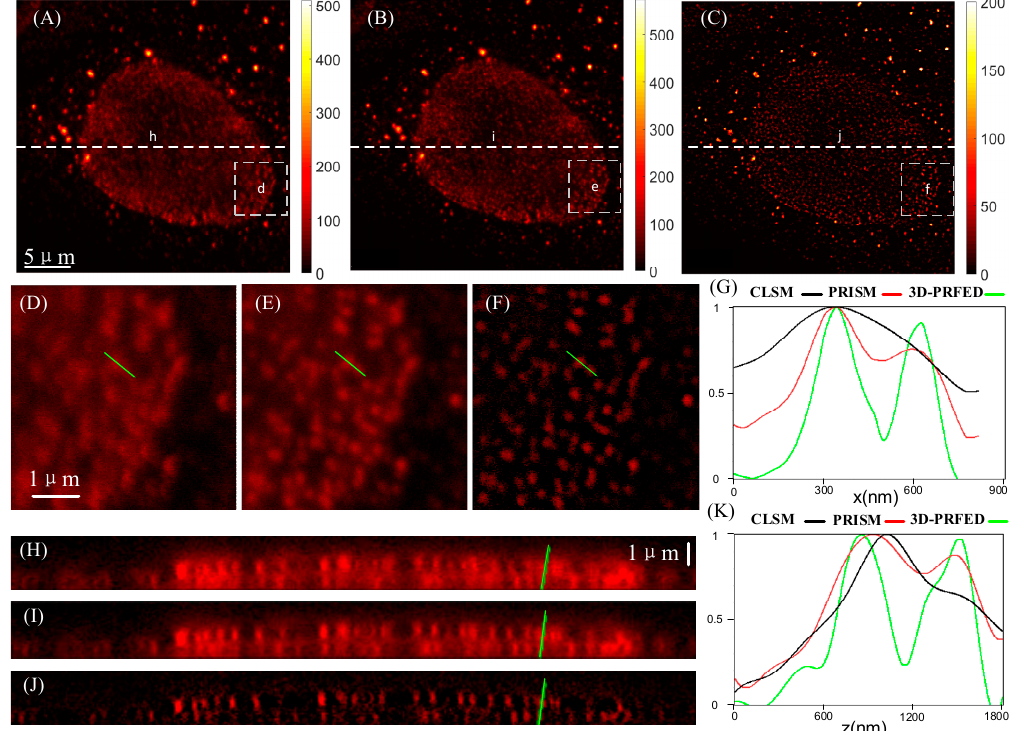
Figure 7. Nuclear pore complex results in CLSM, PRISM, and 3D-PRFED ( γ = 0.7). ( A ) The CLSM image of this NPC sample at 350 nm plane. ( B ) The PRISM image of this NPC sample at 350 nm plane. ( C ) The 3D-PRFED image of this NPC sample at 350 nm plane. ( D – F ) are the local enlarged images in the dashed boxes of ( A – C ) respectively. ( G ) The normalized line profile along the green line in ( D – F ). ( H – J ) are the cross-section views along the dashed line in ( A – C ). ( K ) The line profile along the green line in ( H – J ). Scanning parameter: 6 μ s/pixel, 30 nm transverse pixel size, 50 nm axial pixel size.